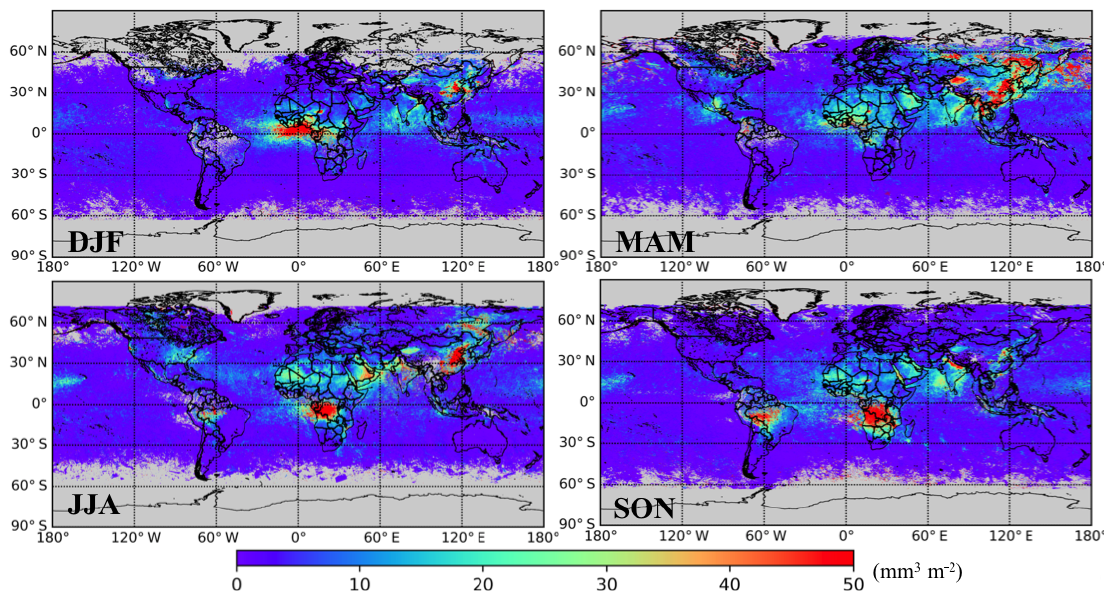
Figure 21. Same as Fig. 16, but for fine-mode non-absorbing insoluble (FNAI, dust, and